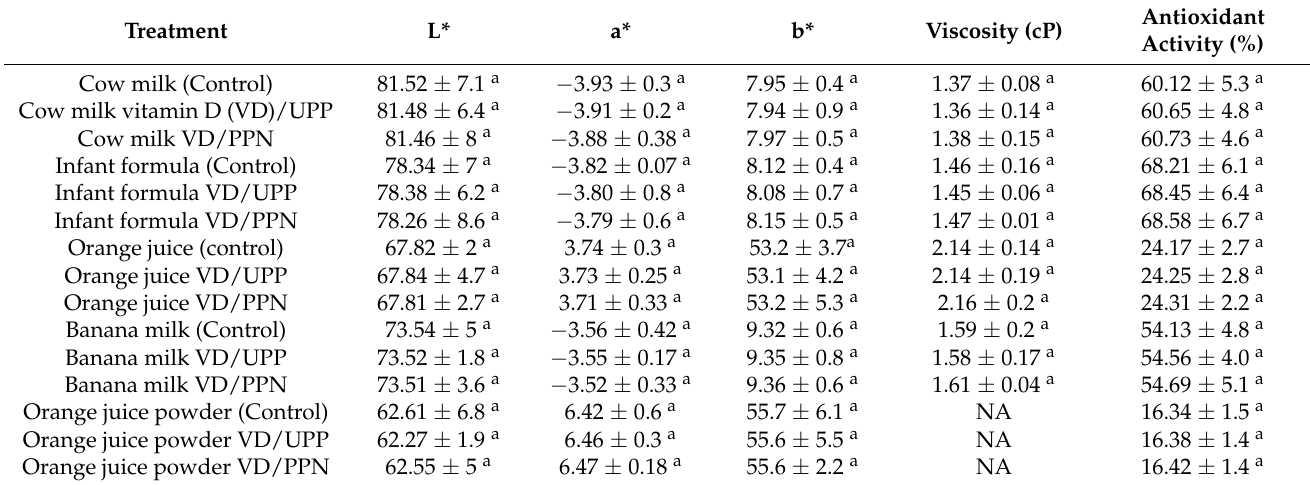
Table 4. Analysis of color, viscosity, and antioxidant activity in formulations.